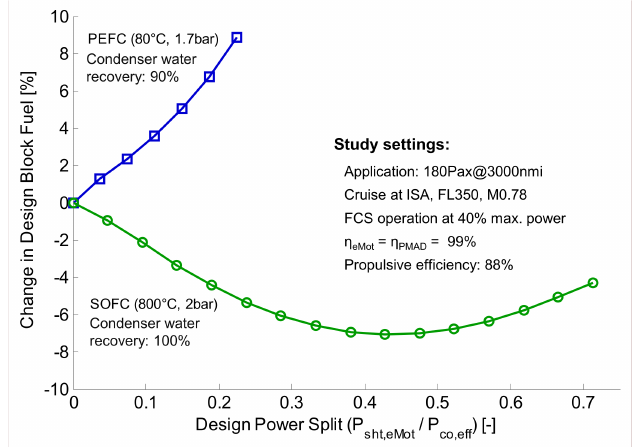
Figure 12. Aircraft design block fuel trends for selected PEMFC and SOFC technology cases versus design cruise power split.